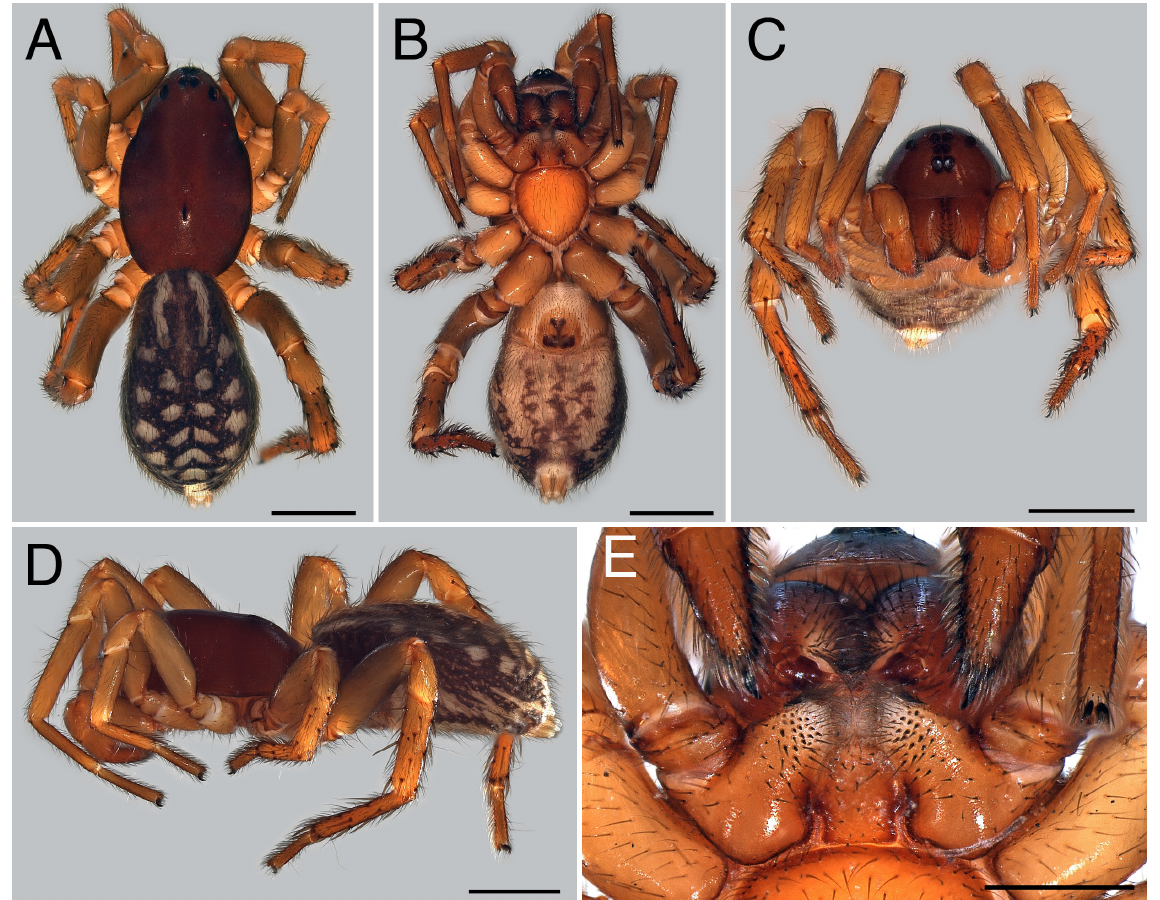
Fig. 9. Ballomma legala gen. et sp. nov. Holotype, ♀. A . Habitus, dorsal view. B . As preceding, ventral view. C . As preceding, frontal view. D . As preceding, lateral view. E . Mouth parts, ventral view. Scale bars: 1